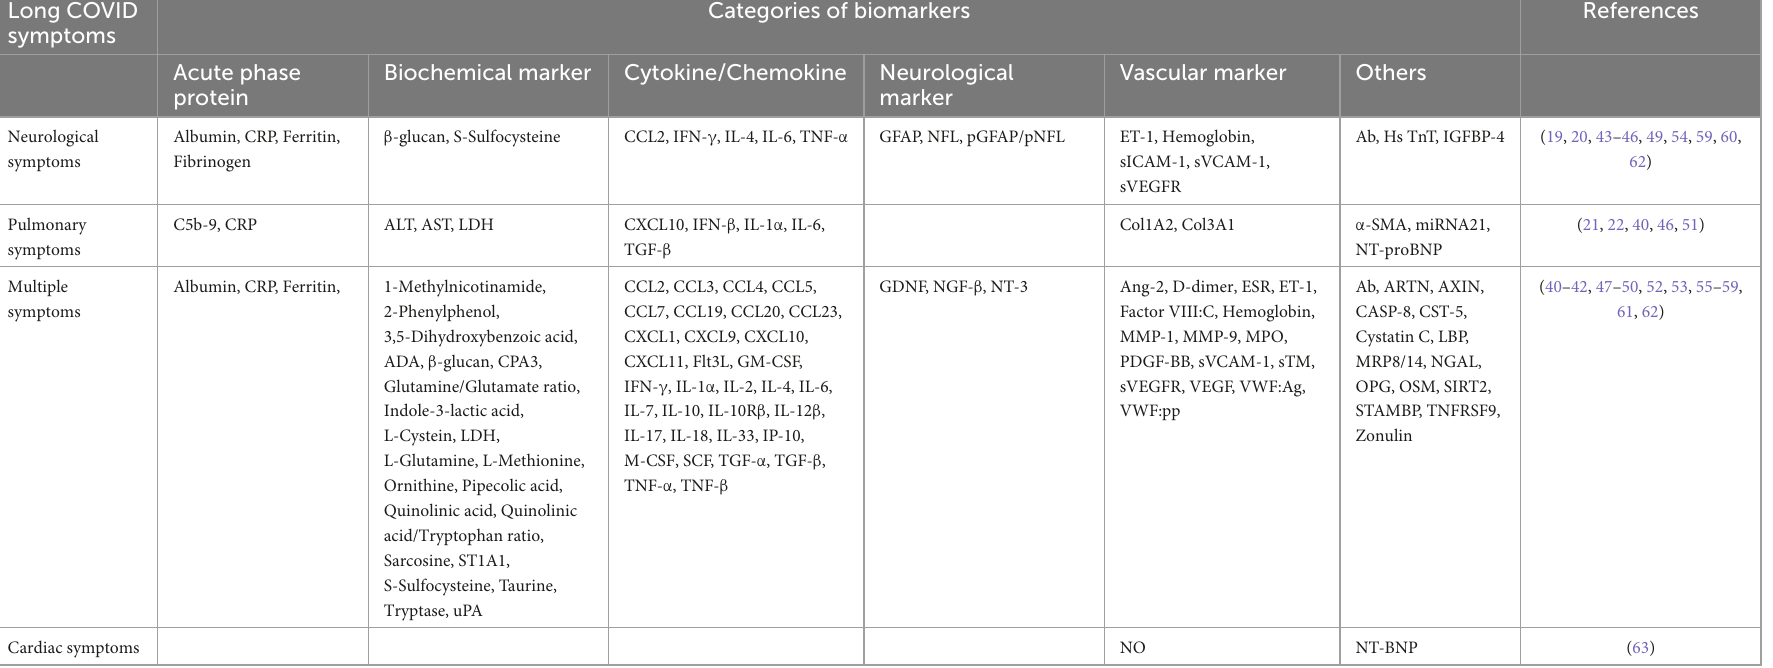
TABLE 3 Biomarkers significantly associated with long COVID